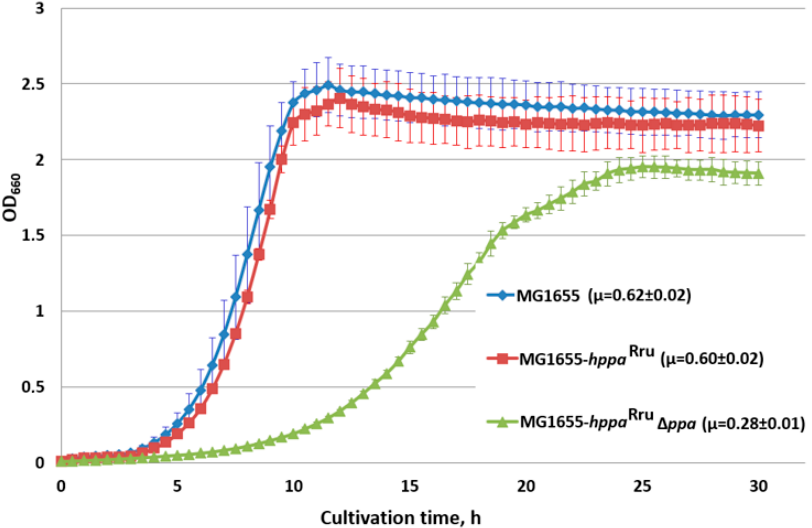
Figure 3. Growth of strains with the hppa Rru gene in the presence and absence of E. coli ppa . Cells were grown with aeration in L-tubes with M9 minimal medium supplemented with 0.3% of glucose at 37 ◦ C in an Advantec photorecorder. MG1655, MG1655 wild-type; MG1655- hppa Rru , MG1655 IS 5.8::P L - hppa Rru ; MG1655- hppa Rru ∆ ppa , MG1655 IS 5.8::P L - hppa Rru ∆ ppa . Average data are shown; bars refer to standard deviations from three independent experiments.